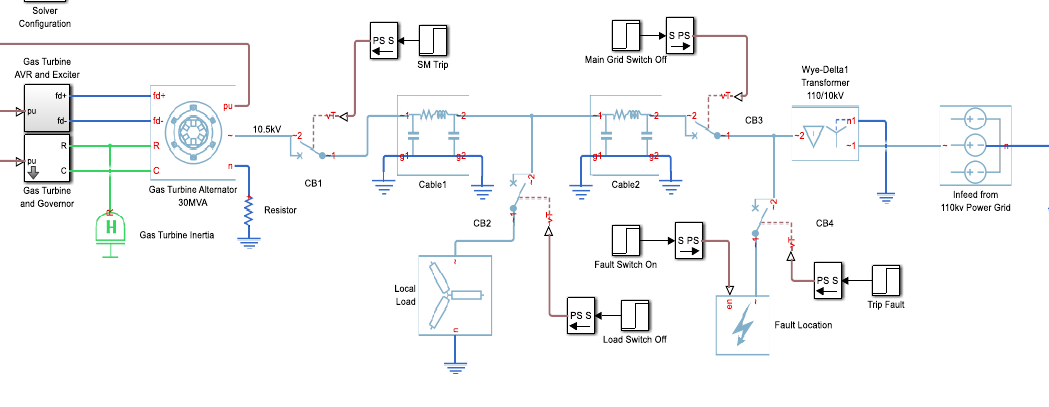
Figure 6. Simulation model. Table 2. Simulation parameters.